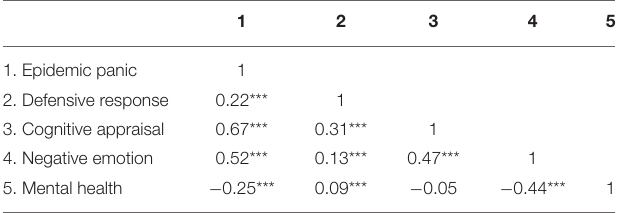
TABLE 2 | Correlation between stress response, negative emotion, and mental